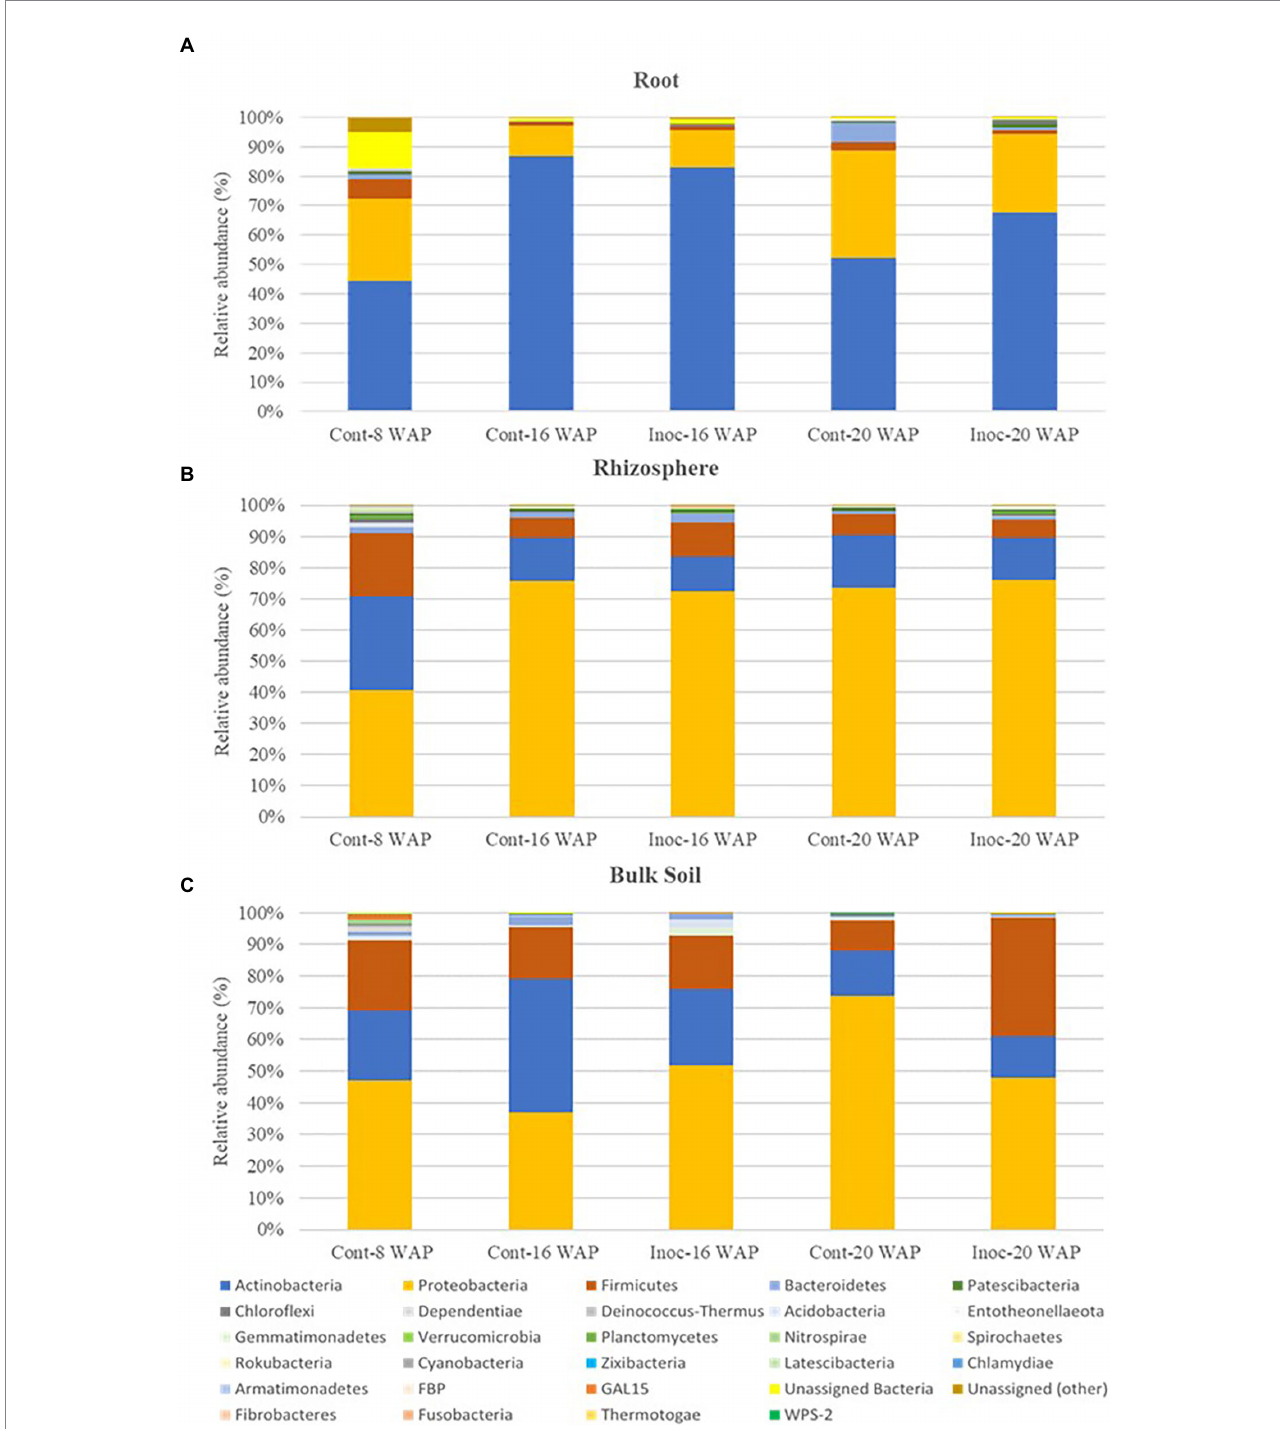
FIGURE 4 Average relative abundance of bacteria at the phyla level in the root (A) , rhizosphere (B) , and bulk soil bacterial communities (C) . Cont, control non- inoculated treatment; Inoc, inoculation treatment; WAP, weeks after